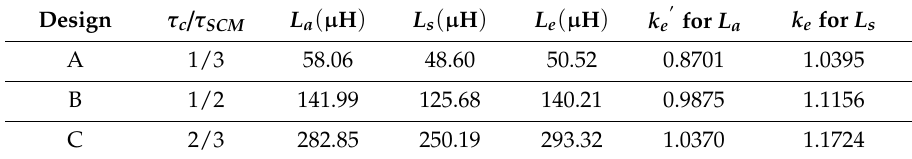
Table 3. Calculation of the coupling e ff ect and e ff ective inductance values for the three selected designs.